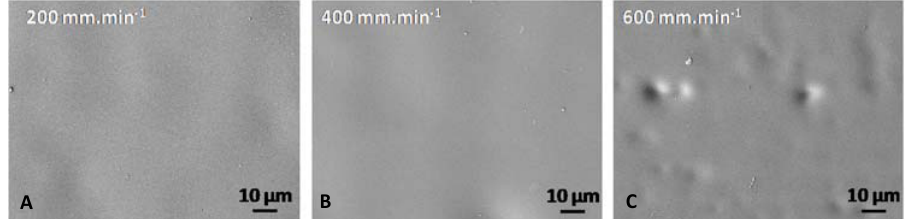
Figure 7. Coating surface micrographs for monolayer systems by scanning electron microscopy (SEM) performed for deposits with withdrawal speed ( A ) 200 mm min − 1 , ( B ) 400 mm min − 1 and ( C ) 600 mm min − 1 .